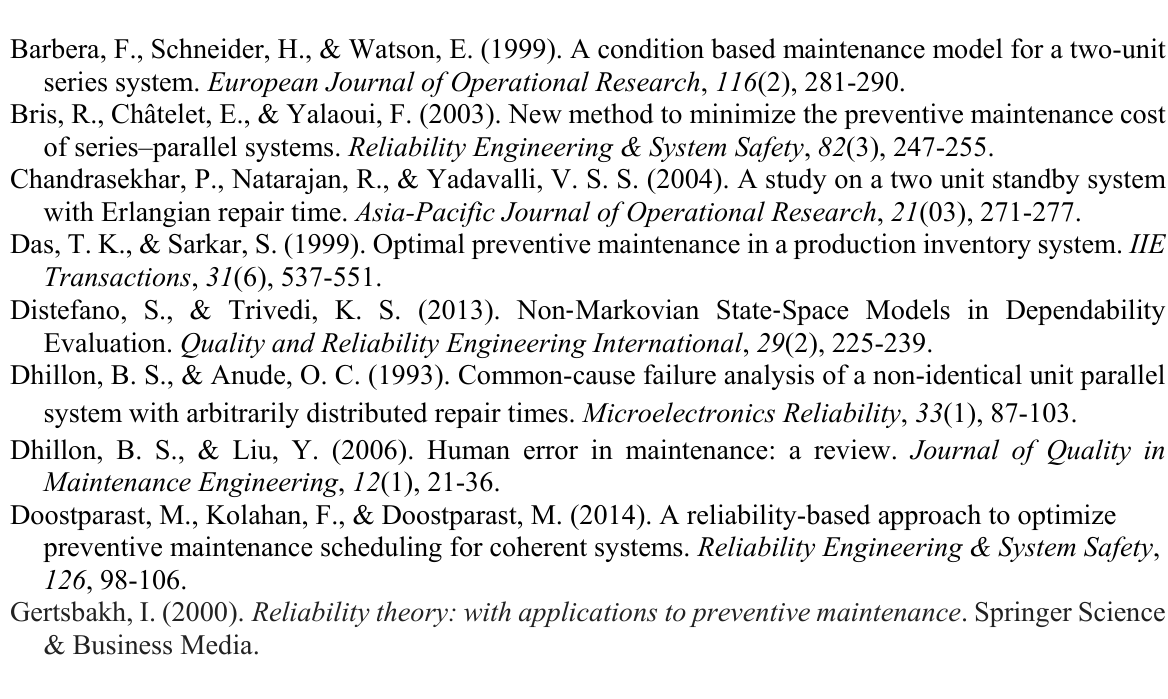
Fig. 4. Busy period vs Failure Rate Fig. 5. Profit vs Failure